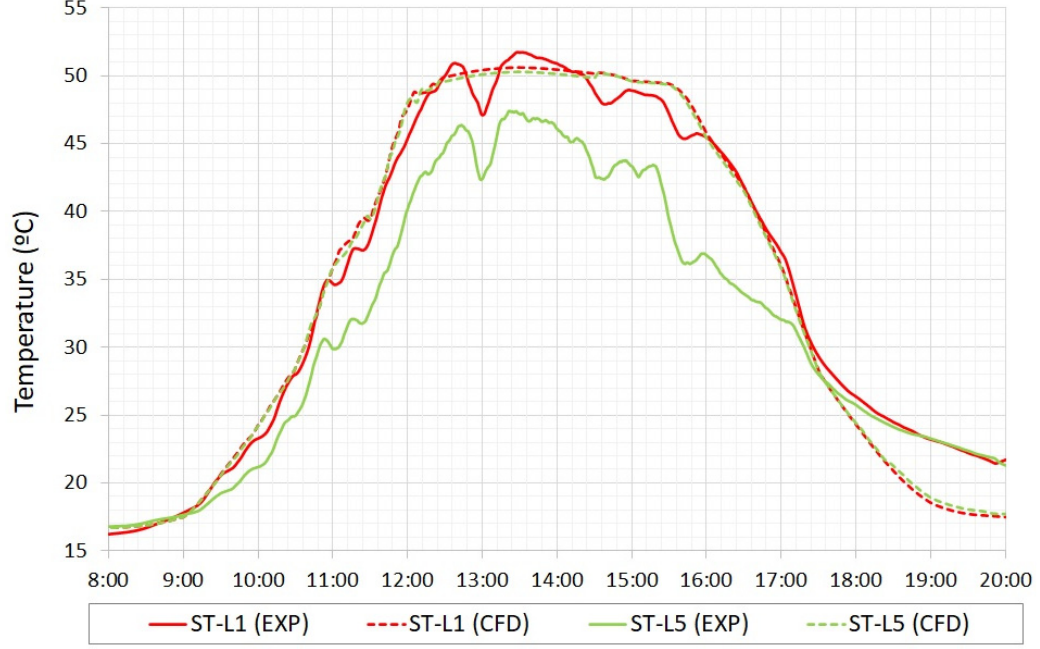
Figure 9. Slat surface temperature validation.